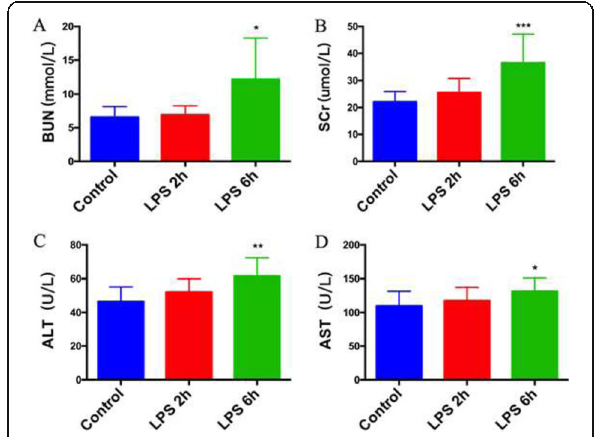
Fig. 1 (abstract 0162). effect of PBS or LPS treatment on renal function and liver function in rats